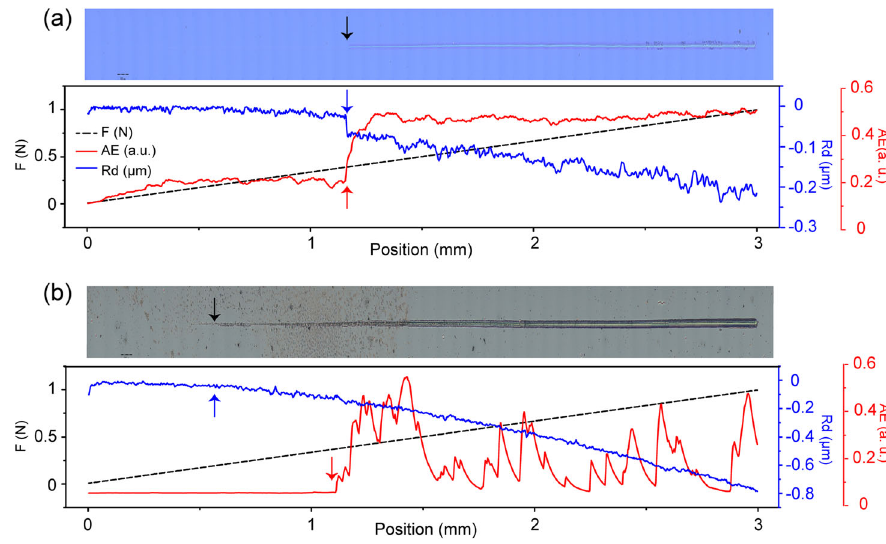
Fig. 3 Scratch tests of a TiAlN(30nm)-TiN(50nm) coating on a sapphire substrate, and b Si(50nm)-Cu(50nm) coating on a sapphire substrate. F: load in the form of mechanical force on the coating; AE: acoustic emission; Rd: residual depth of the sample after the scratch tests. The black arrows indicate the optical microscopy observation of the starting point of damage (critical loads) on the coatings, which is confirmed by the simultaneous measurement of Rd (blue arrows). The Rd rapidly decreases after the critical loads is reached. The red arrows mark the critical loads for the dramatic increase of AE and the width of the scratch is wider compared to that on the TiAlN-TiN coating. This